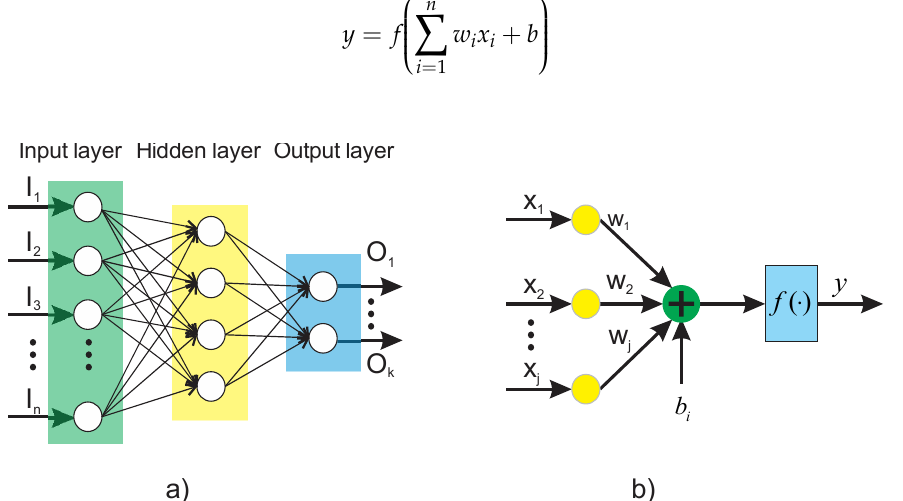
Figure 3. Artificial neural network: ( a ) feed – forward neural network (FFNN) architecture; ( b ) functional structure of a neuron.